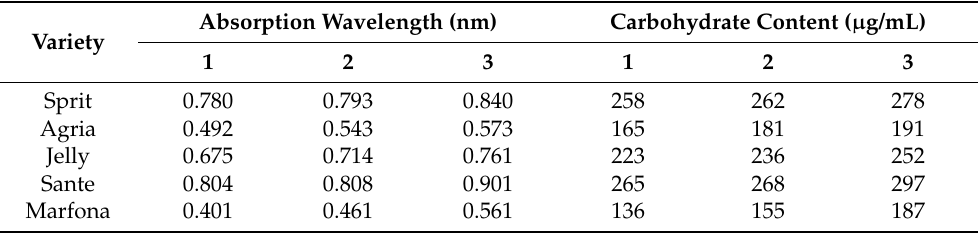
Table 1. Carbohydrate values obtained for different potato cultivars.